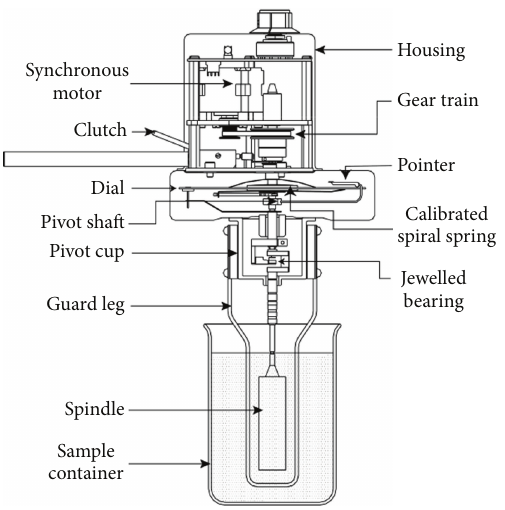
Figure 1: The principle of Brookfield DV-III